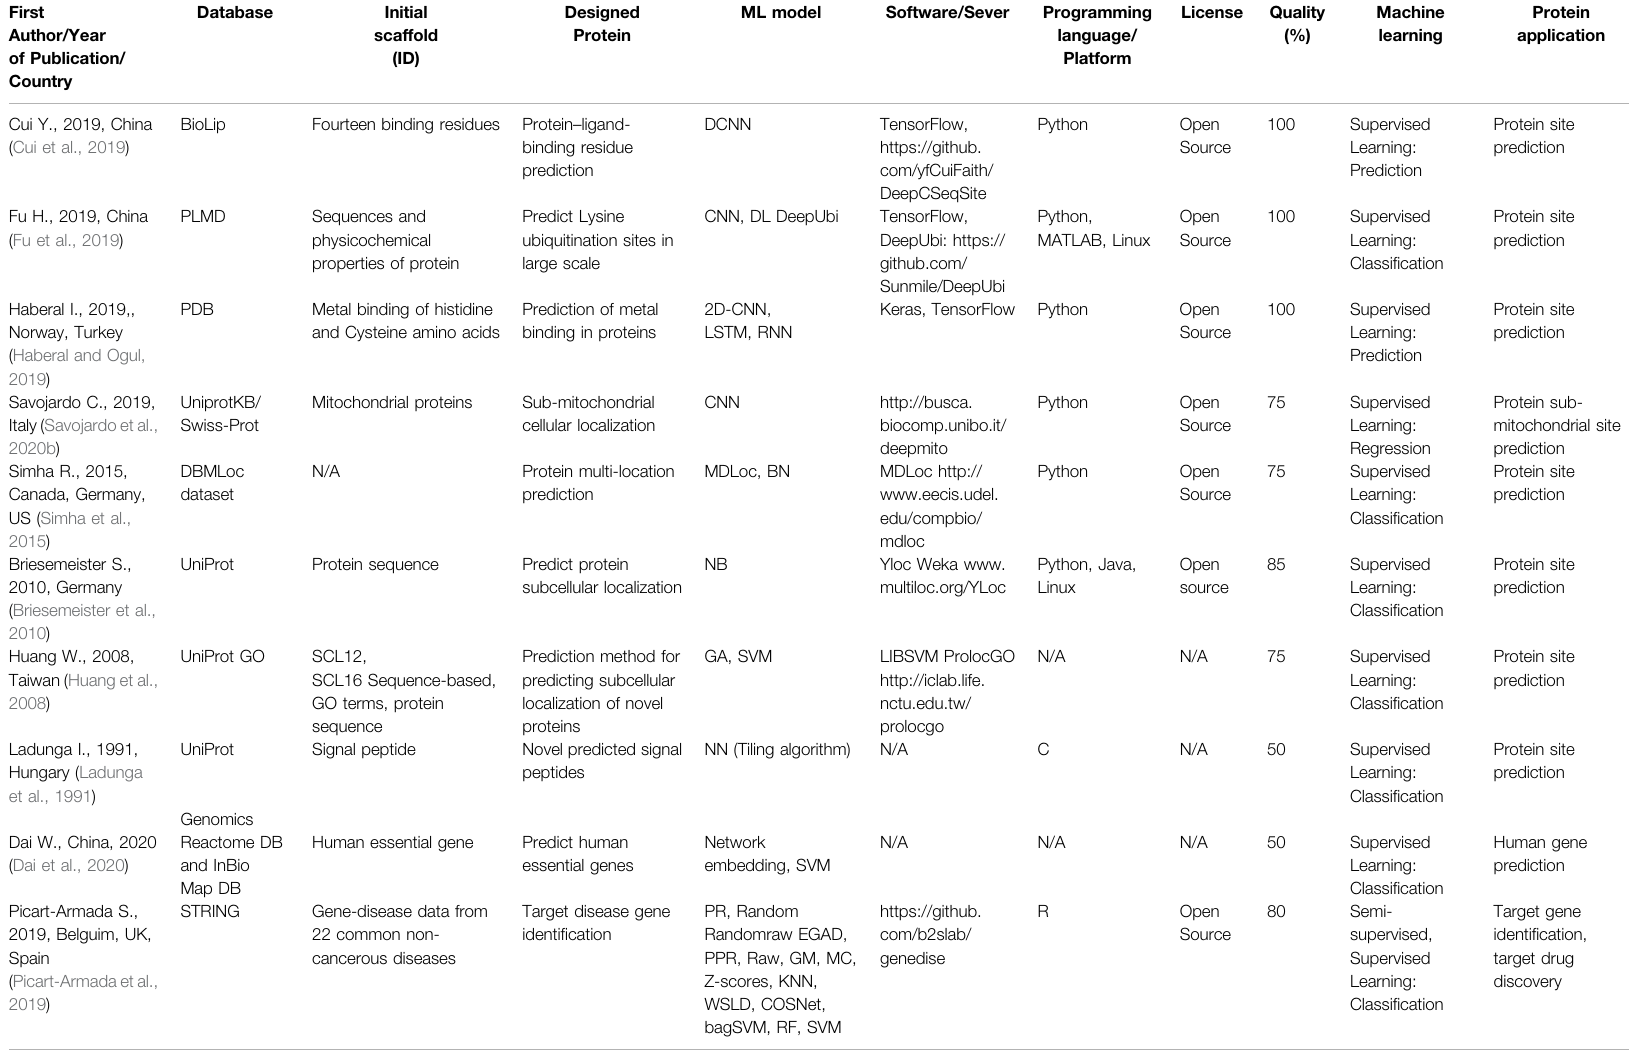
TABLE 6 | ( Continued ) An overview of the protein contact map prediction, protein-binding prediction, protein site prediction, and genomics articles with the quality